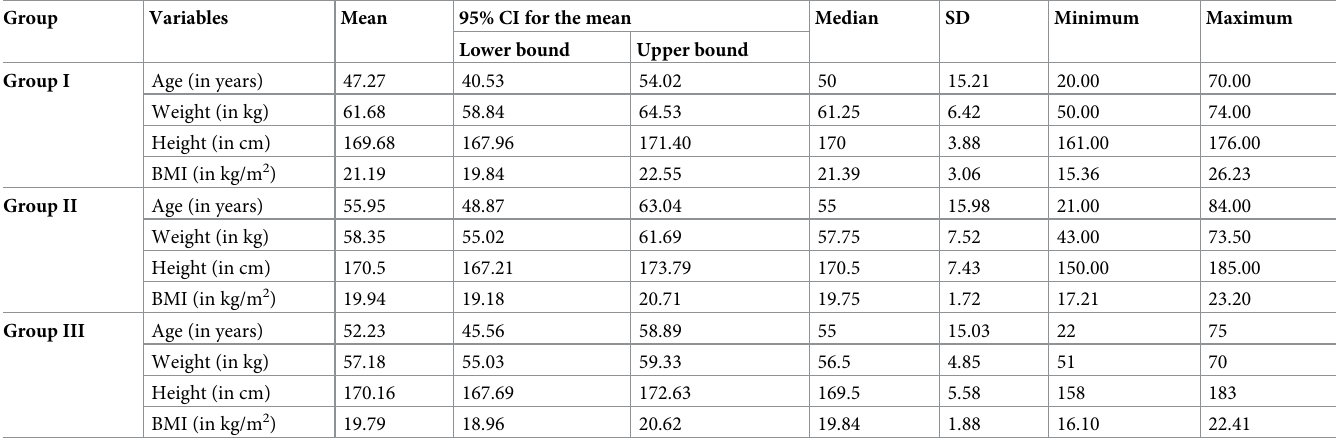
Table 1. Sociodemographic data of